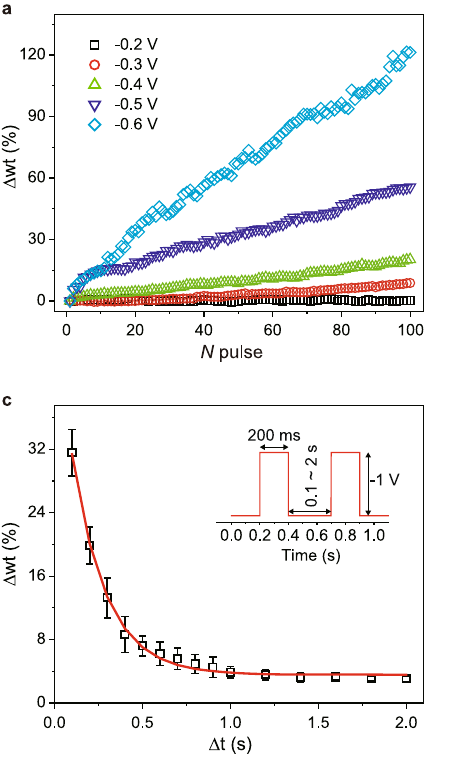
decay (time constant, 192ms) with the time interval of the paired-pulse. d Spike- timing-dependent plasticity of the molecular synapse. The solid lines are expo- nential fi ttingwiththetimeconstantsof560ms( blue )and308ms( red ).Theinsets in ( b ) – ( d ) are the placed pulses. The error bars in ( b ) and ( c ) are based on ten independent